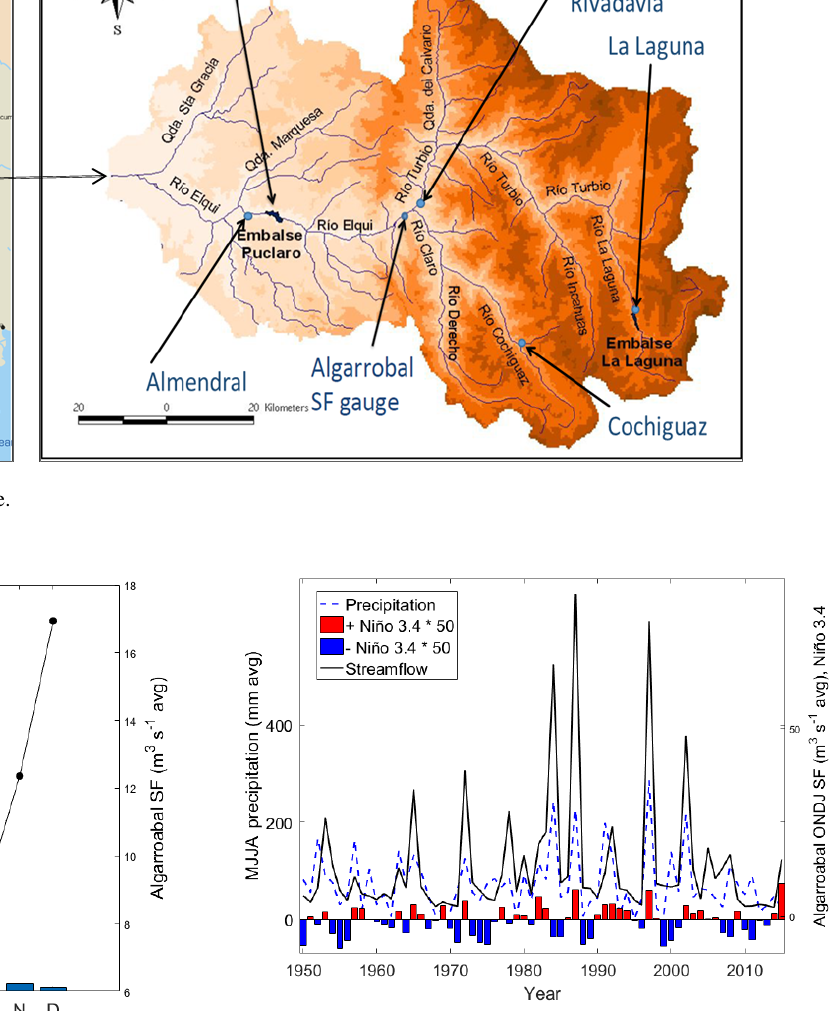
Figure 3. Total annual precipitation (dashed), streamflow (solid), and May–August Niño 3.4 sea surface temperature anomalies